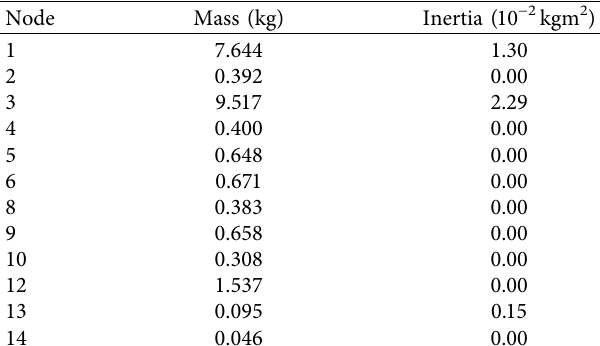
Figure 2: Studied mechanism: finite element model (a) variables involved in the estimation process (b). Table 1: Lumped masses and nodal inertia.